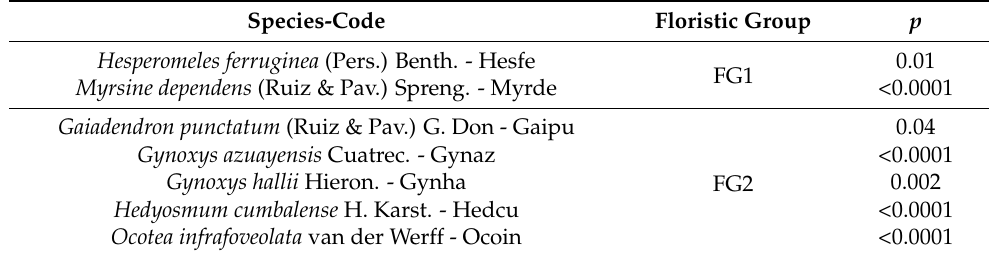
Figure 2. Non-multidimensional metric scaling analysis (NMDS) with three floristic groups and their indicator species of Montane Forest. The codes of the indicator species are described in Table 1. FG: floristic groups. Table 1. Indicator species for each floristic group and successional status of Montane Forest.